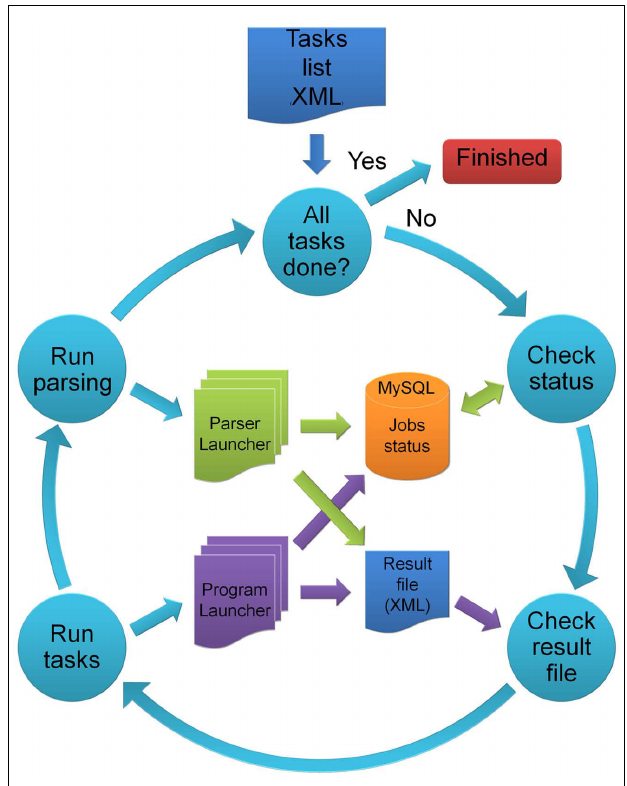
FIGURE 3 | Schematic representation of the master program (MP). “Tasks list”: list of tasks to be executed and their parameters (XML file). Each task may depend on the results produced by a preceding task and this information is also specified in the XML file.When all the dependencies are satisfied for a given task, it is submitted to the computing cluster by running a “Program Launcher” job (Run tasks).When the “Program Launcher” is completed, a “Parser Launcher” job is submitted (Run parsing) to generate GFF and EMBL files from the program output.These scripts update their status in a MySQL database and write XML files to summarize the execution result.The main program checks both the database (Check Status) and the result files (Check result files) to monitor running jobs.When all tasks are completed, the master program ends the pipeline